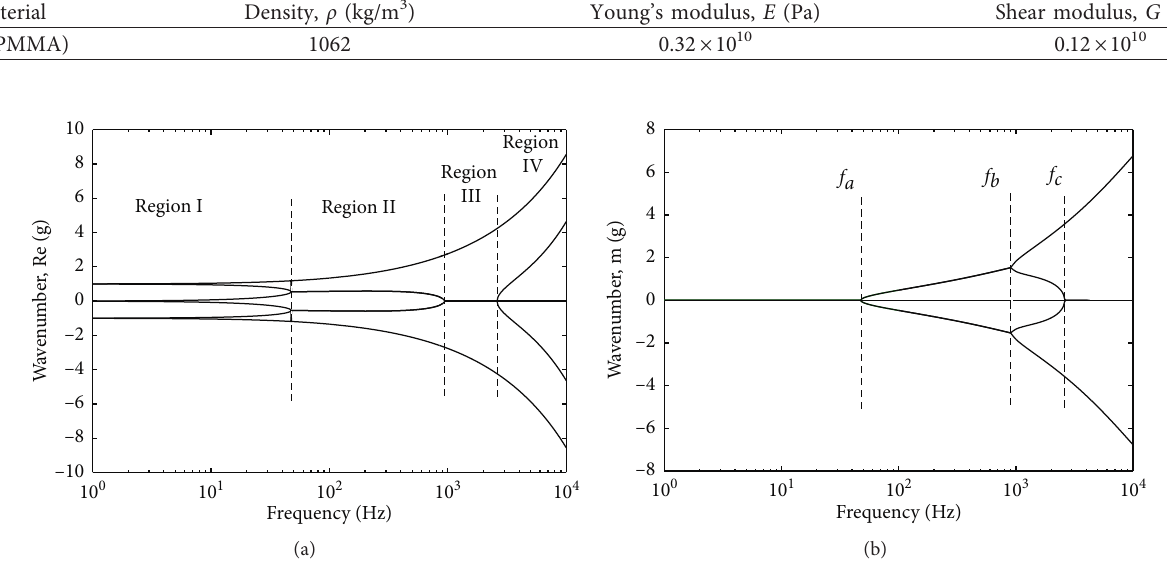
Figure 2: Dispersion relations of out-of-plane vibration of a curved beam. (a) Real wavenumber values. (b) Imaginary wavenumber